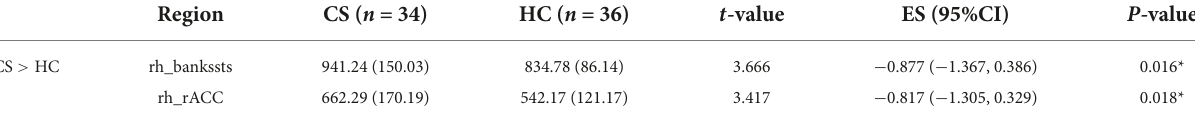
TABLE 3 Differences in surface area index between the two